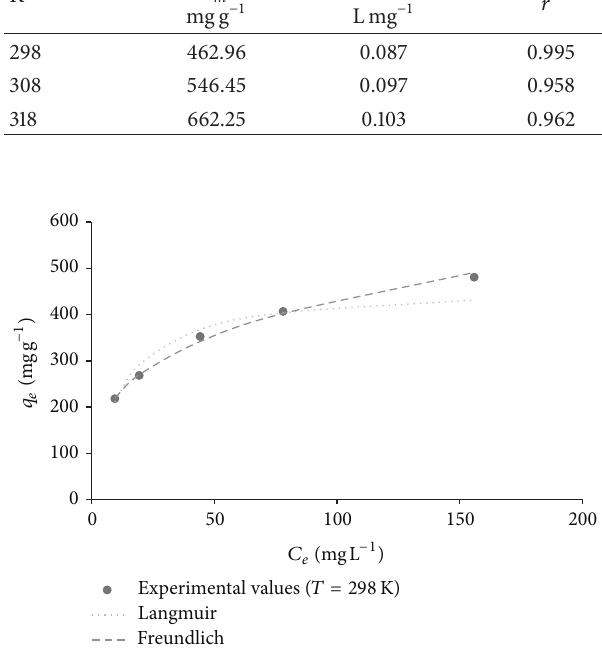
Figure 9: The Langmuir and Freundlich isotherms for the adsorp- tion of MB onto CHAC Z (adsorbent dose: 0.3 gL −1 ; pH: 4; tempera- ture: 298 K).